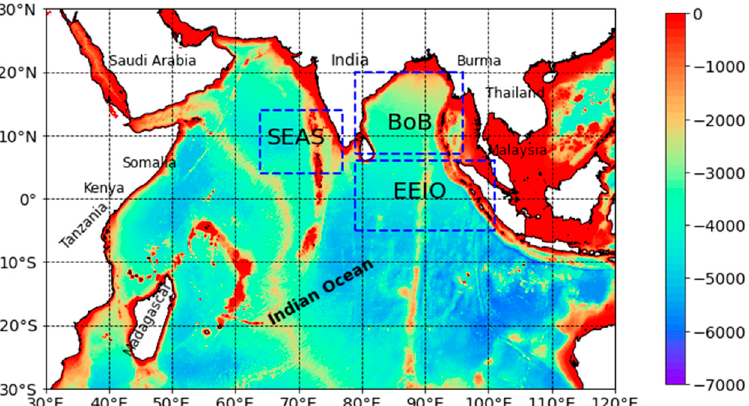
Figure 2. The study area used in this research.